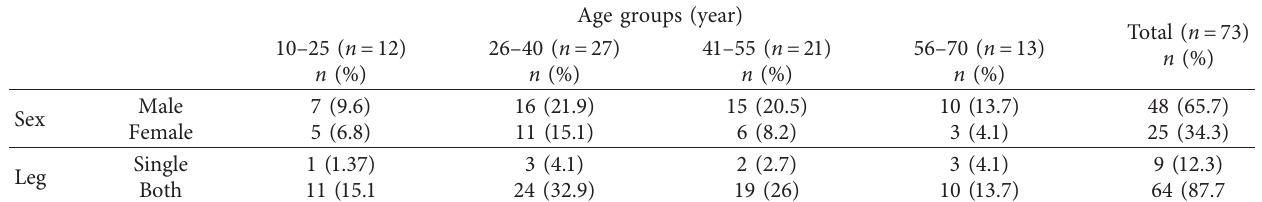
Table 1: Sex and age distribution of podoconiosis cases ( n � 73) in Jeldu district, West Shoa, Ethiopia.